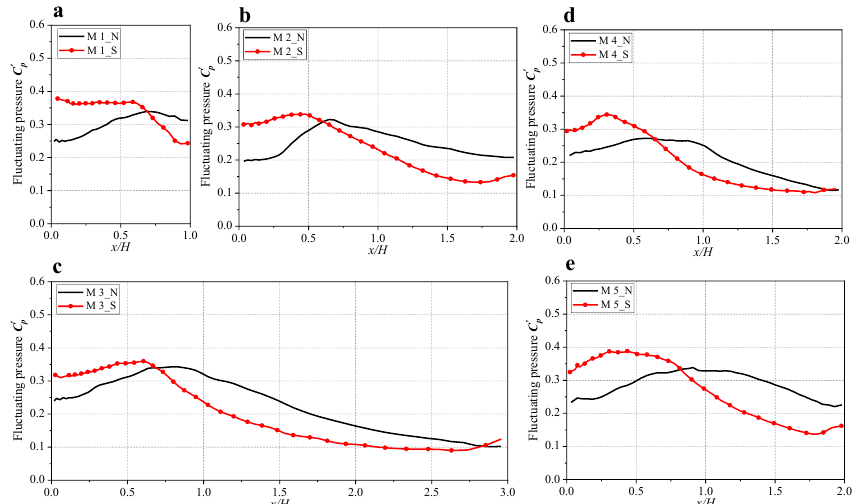
Figure 12. The distributions of fluctuating pressure coefficient ( 𝐶 𝑃′ ) along the roof axis (( a ) M1; ( b ) M2; ( c ) M3; ( d ) M3; ( e ) M4).